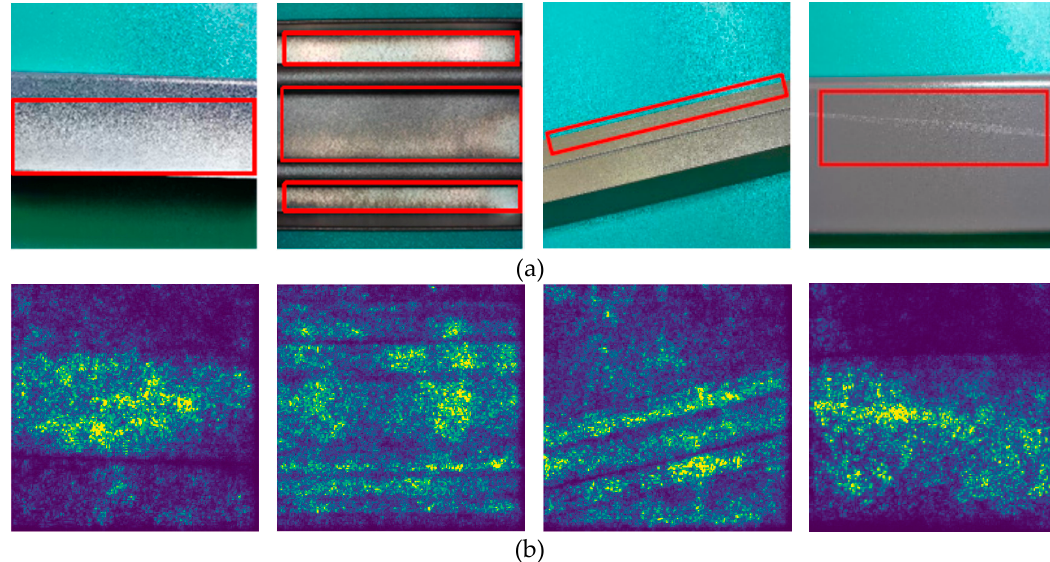
Figure 13. ( a ) Aluminum profile defect images; ( b ) saliency maps.